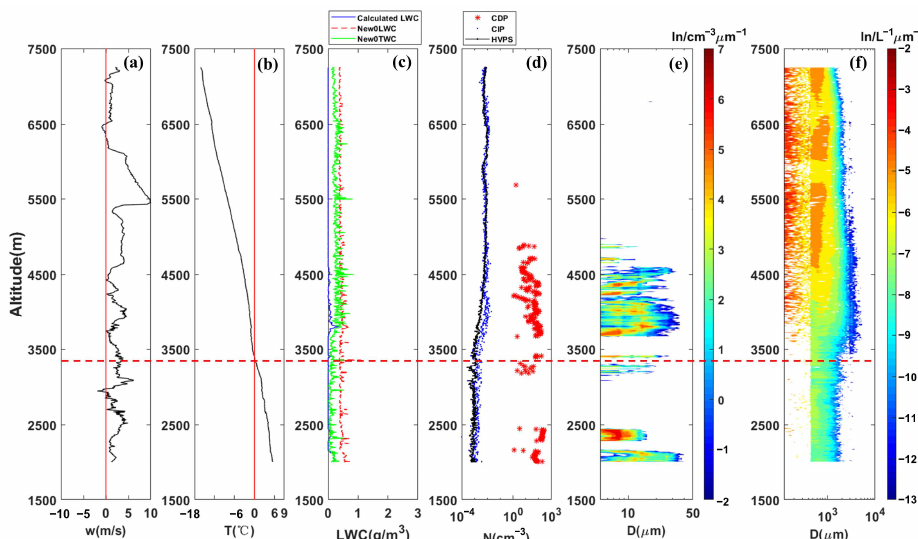
Figure 10. The aircraft observation data set of V4 on 22 May 2017 in the stratiform cloud area, ( a ) vertical velocity (the red line is 0, units: m s −1 , °C); ( b ) temperature (units: °C, the red line is 0); ( c ) calculated liquid water content (calculated LWC), probe detected liquid water content (New0LWC), probe detected total water content (New0TWC) (units: g m −3 ); ( d ) particle number concentration of the CDP, the CIP, and the HVPS (units: cm −3 ); ( e ) particle spectrum of CDP (units: cm −3 µm −1 ); ( f ) particle spectrum of the CIP (100–400 µm) and the HVPS (400–8700 µm) (units: L −1 µm −1 ). The red do(cid:308)ed line is the 0 °C layer. Table 3. Comparison of microphysical quantities at different stages.